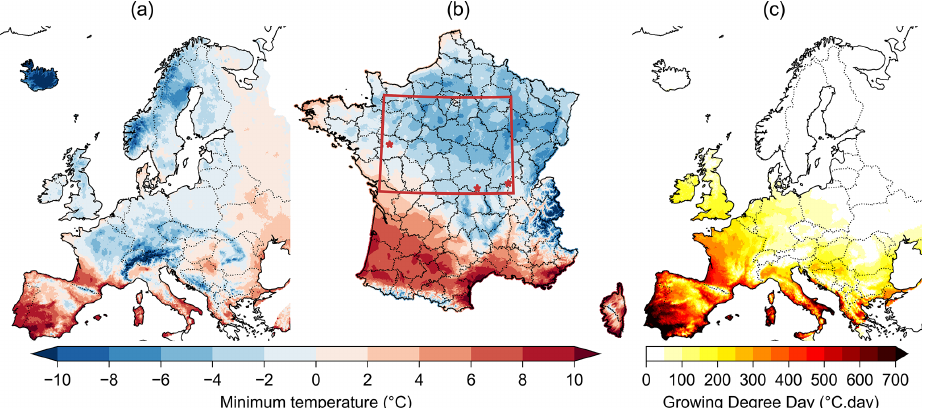
Figure 2. (a) Minimum temperatures on 6 April 2021 in Europe from the E-OBS (Cornes et al., 2018) database (see Sect. 3); (b) focus on France with a higher resolution dataset, using the Anastasia data (Météo-France, Besson et al., 2019). The study area is shown in this panel by the bounded box in red; stars indicate the location of the three stations used to assess local trends; (c) spatial distribution of the growing degree day index in Europe on 5 April 2021 as calculated from